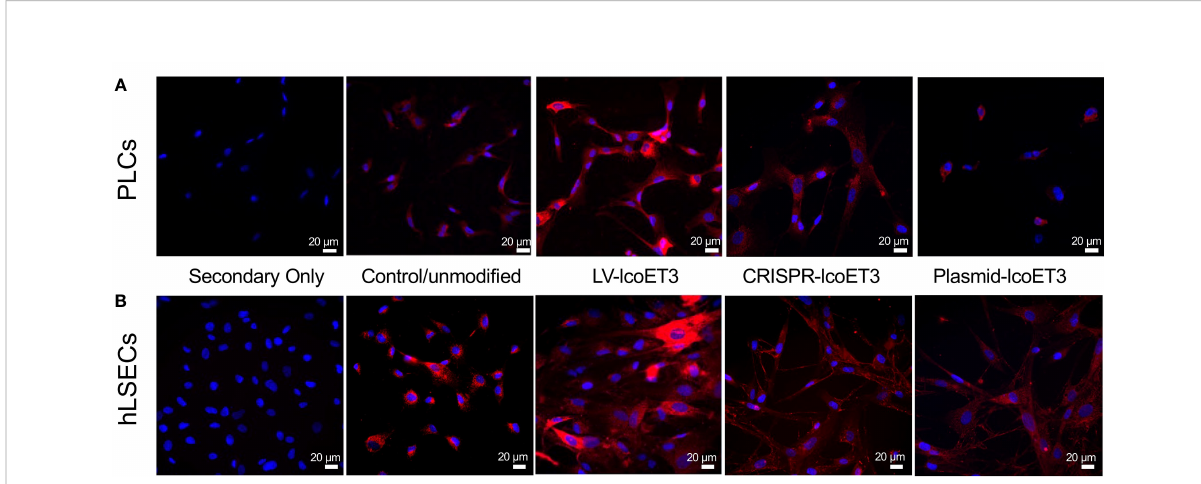
FIGURE 4 Representative images of immuno fl uorescence analysis of intracellular FVIII protein in unmodi fi ed and gene-modi fi ed PLCs and hLSECs. PLCs (A) and hLSECs (B) in each treatment group were stained with a primary antibody speci fi c for FVIII that was then detected with an AlexaFluor ® 594-conjugated secondary antibody (red) and nuclei were counterstained with DAPI (blue). Controls consisted of slides with unmodi fi ed PLCs and hLSECs stained identically and slides of each cell type stained with secondary antibody alone to establish levels of background fl